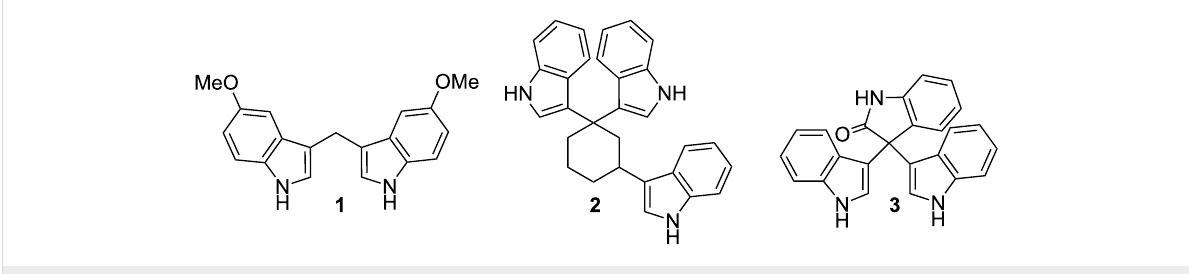
Figure 1: Bisindolyl based important targets: 1 [21], 2 [22] and 3 [23].